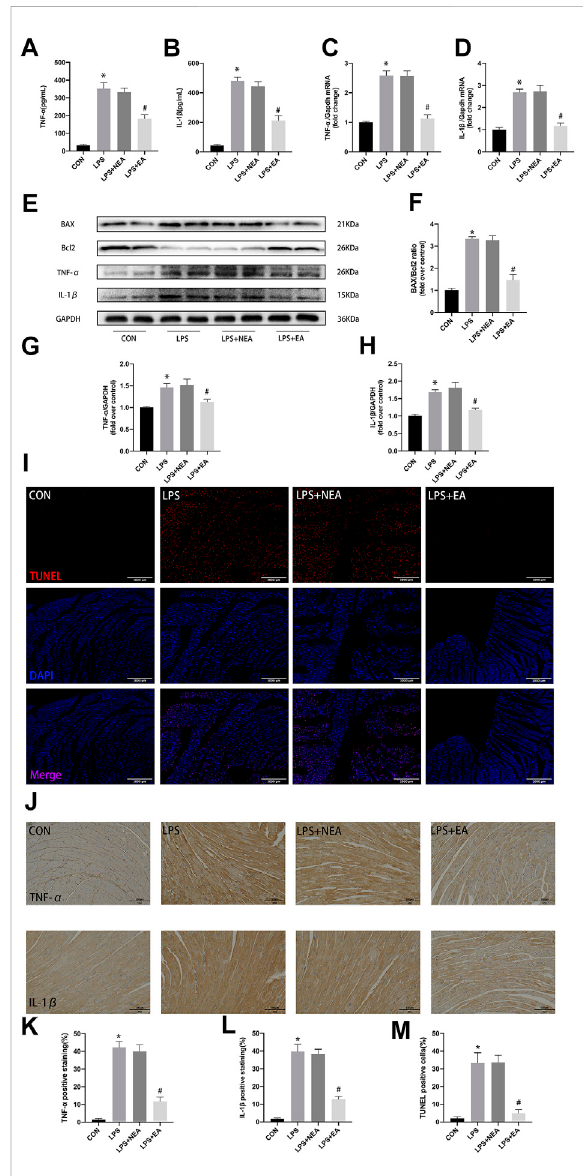
Effect of EA pre-treatment on myocardial in fl ammatory response and apoptosis. (A,B) Serum concentrations of TNF- α and IL-1 β . (C,D) mRNAexpressionof Tnf- α and Il-1 β . (E) Representative images of western blots for BAX,Bcl2,TNF- α , IL-1 β , and GAPDH. (F – H) Quantitative results of BAX\Bcl2, TNF- α and IL-1 β . (I) TUNEL staining, apoptosis positive cells (red), nuclei (blue). (J) Immunohistochemistry results of TNF- α , IL-1 β . (K,L) Quantitative analysis for TNF- α and IL-1 β . (M) Quantitative analysis for TUNEL postive cells. N = 4 per group. EA, electroacupuncture; NEA, EA in non-acupoint; LPS, lipopolysaccharide. * p < 0.05 vs. control group, # p < 0.05 vs. LPS